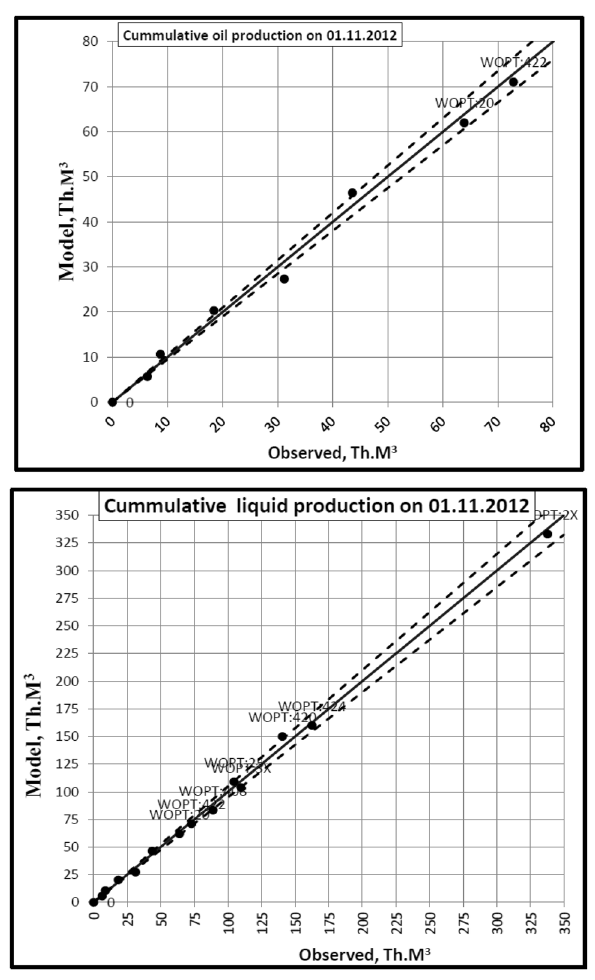
Fig. 12 Cross‑plot of cumulative oil and liquid